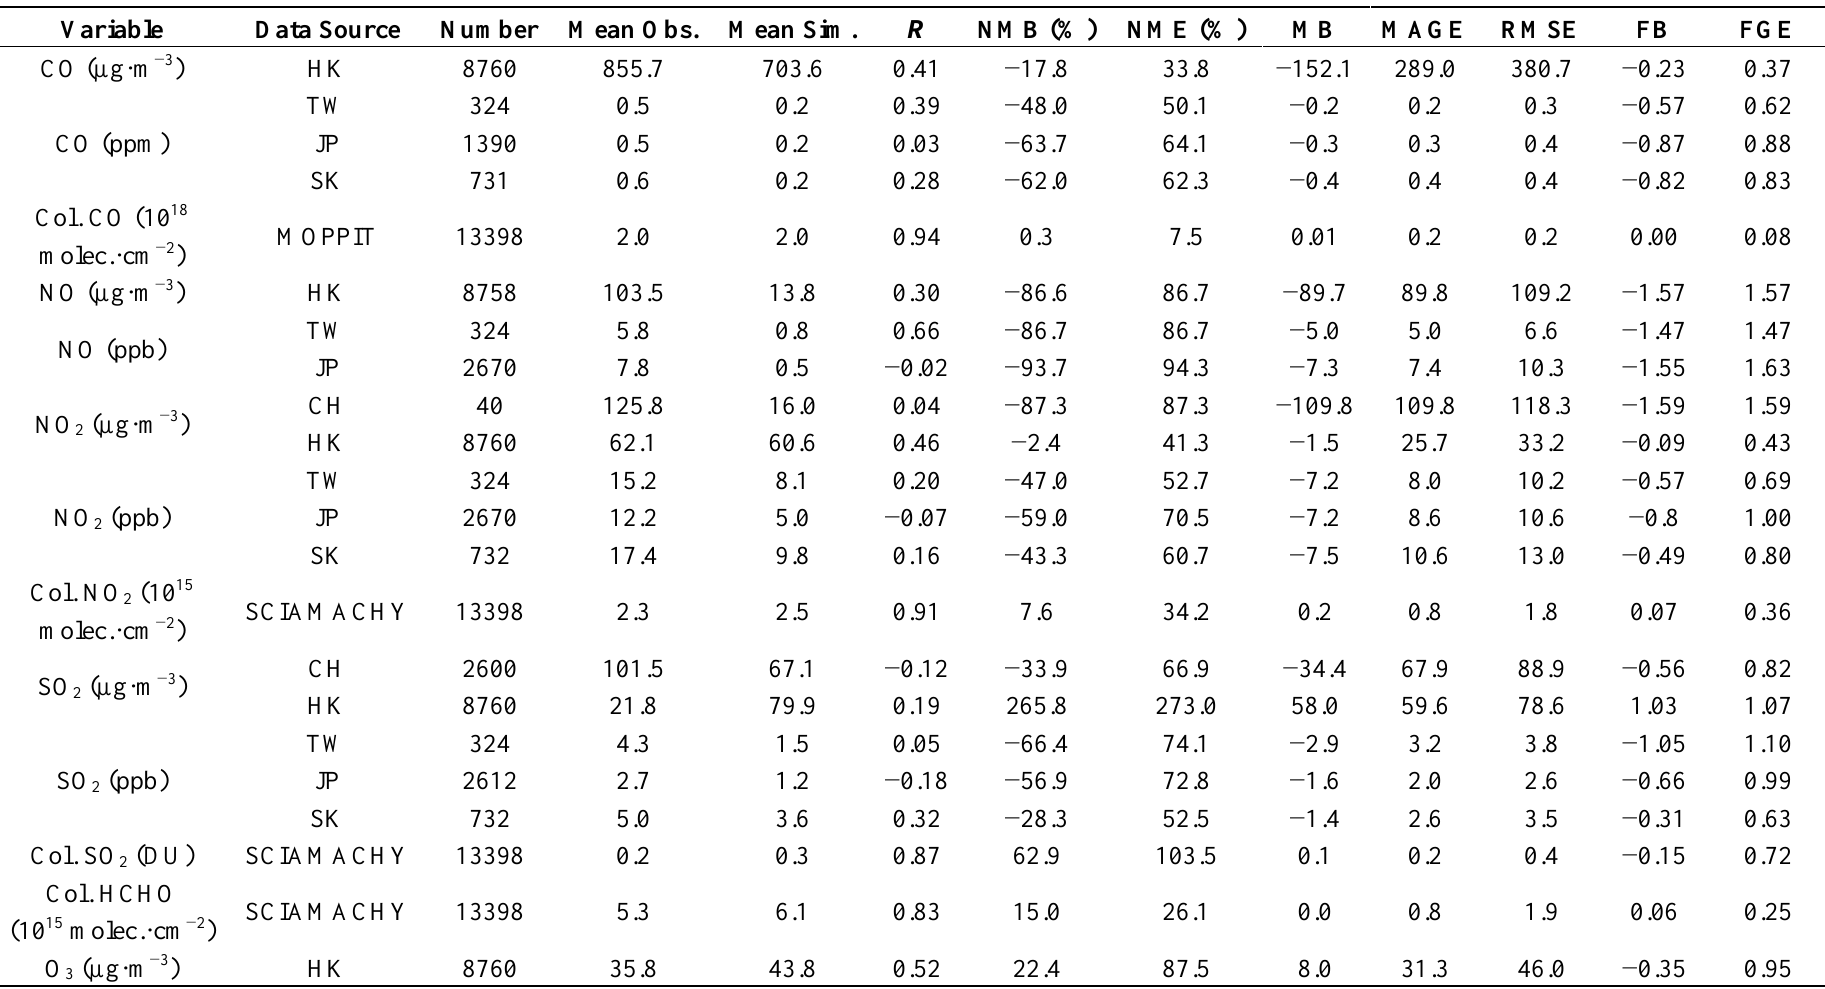
Table 4. Performance statistics for surface chemical concentrations and column mass abundance of gaseous species for